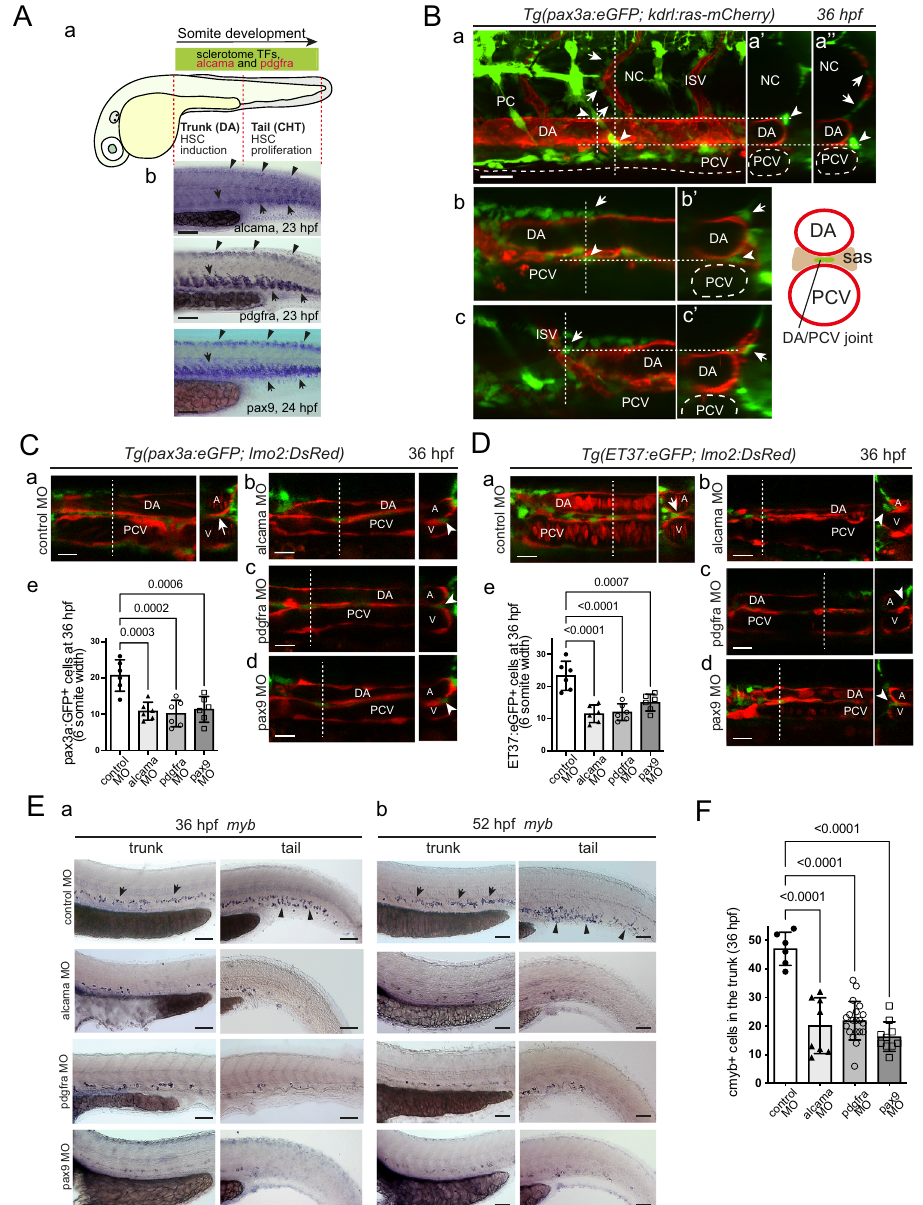
Fig.7|AlcamaandPdgfr- α arealsoinvolvedinstromalcelldevelopmentinthe trunk, which conditions the development of de fi nitive HSPCs. A ( a ) Rostro- caudal extent of sclerotomal TFs and alcama and pdgfra expression by 24 hpf. b WISHfor alcama , pdgfra, and pax9 at23 – 24hpf.Arrowspointattheirexpression in the somite VCs/sclerotome in the trunk and tail. Arrowheads point at their expression inthe smallerdorsalsclerotome 15 . B Confocal maximum projection ( a ) and singleconfocalsections( b , c )ofthe trunkregionofa Tg(pax3a:eGFP; kdrl:ras- mCherry) embryo at 36 hpf, with vertical dashed lines showing the position of the optical transverse sections shown on the right ( a ’ , a ” , b ’ , c ’ ). Arrowheads point at GFP + stromal cells located at the DA/notochord or DA/PCV junction, arrows point at ISV-associated mesenchymal cells, known to originate from the dorsal-wards migrationofventralsclerotomecells 12,15 .Scalebar,20 µ m. C , D Confocalsectionsof thetrunkregionof Tg(pax3a:eGFP;lmo2:DsRed) ( C )and Tg(ET37:eGFP;lmo2:DsRed) ( D ) embryos injected with control ( a ), alcama ( b ), pdgfra ( c ), or pax9 ( d ) MOs. Dashed lines indicate the position of the corresponding transverse section shown on the right. Arrows and arrowheads point at stromal cells located at the DA/PCV